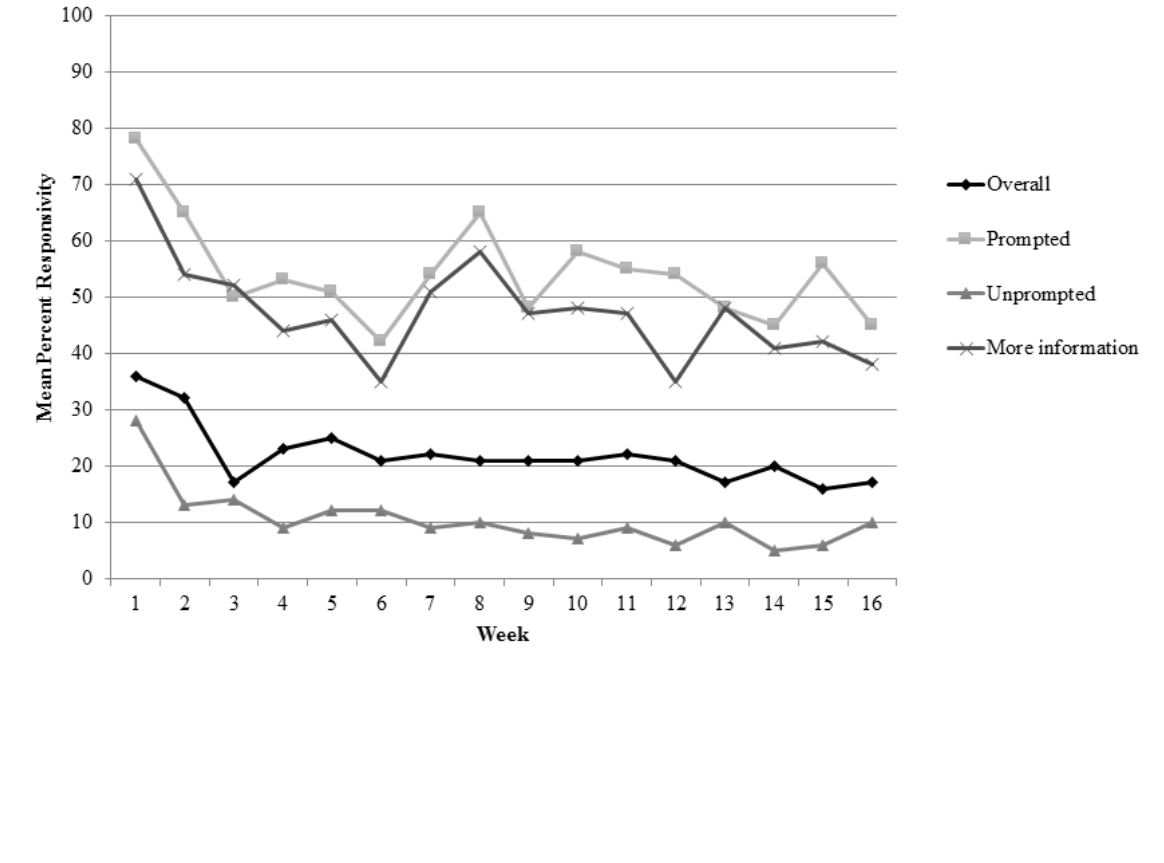
Figure 1. Average responsivity across text messages categories received weekly over a 16-week